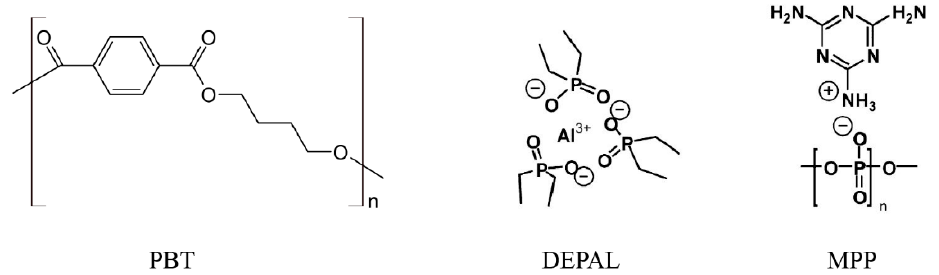
Figure 1. Chemical structures of polymer (polybutylene terephthalate (PBT)) and two flame retardant additives (aluminum diethyl phosphinate (DEPAL) and melamine polyphosphate (MPP)).